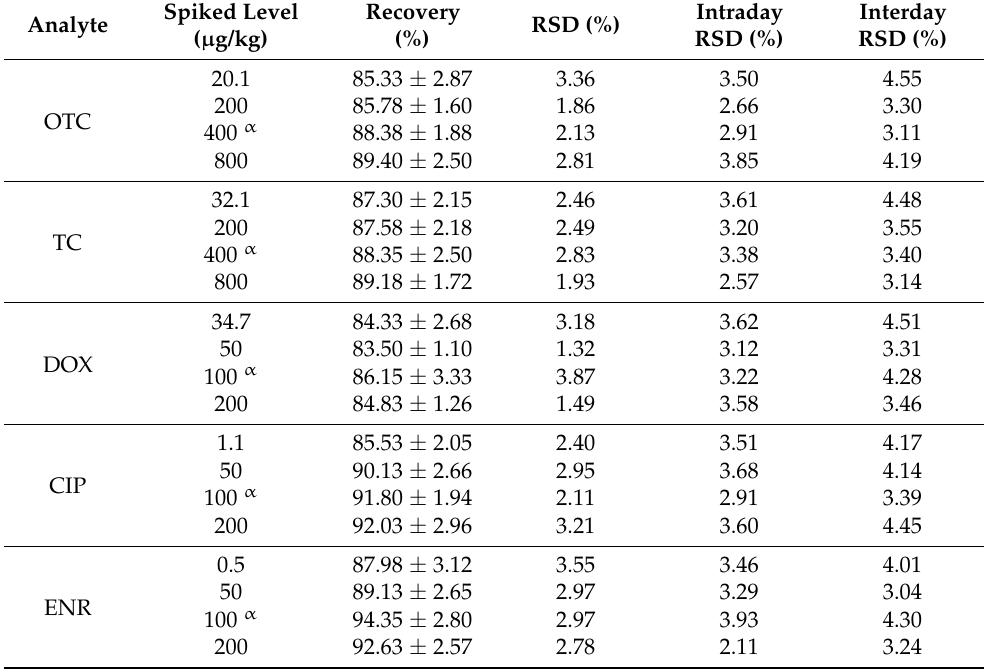
Table 5. Recovery and precision for analyses of blank blended whole duck egg spiked with OTC, TC, DOX, CIP and ENR (n =